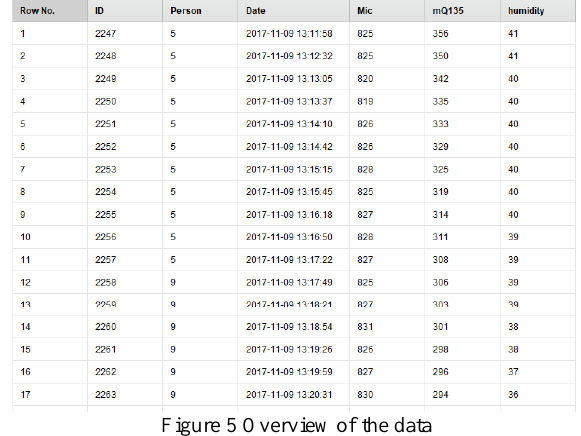
Figure 3 Data Acquisition System